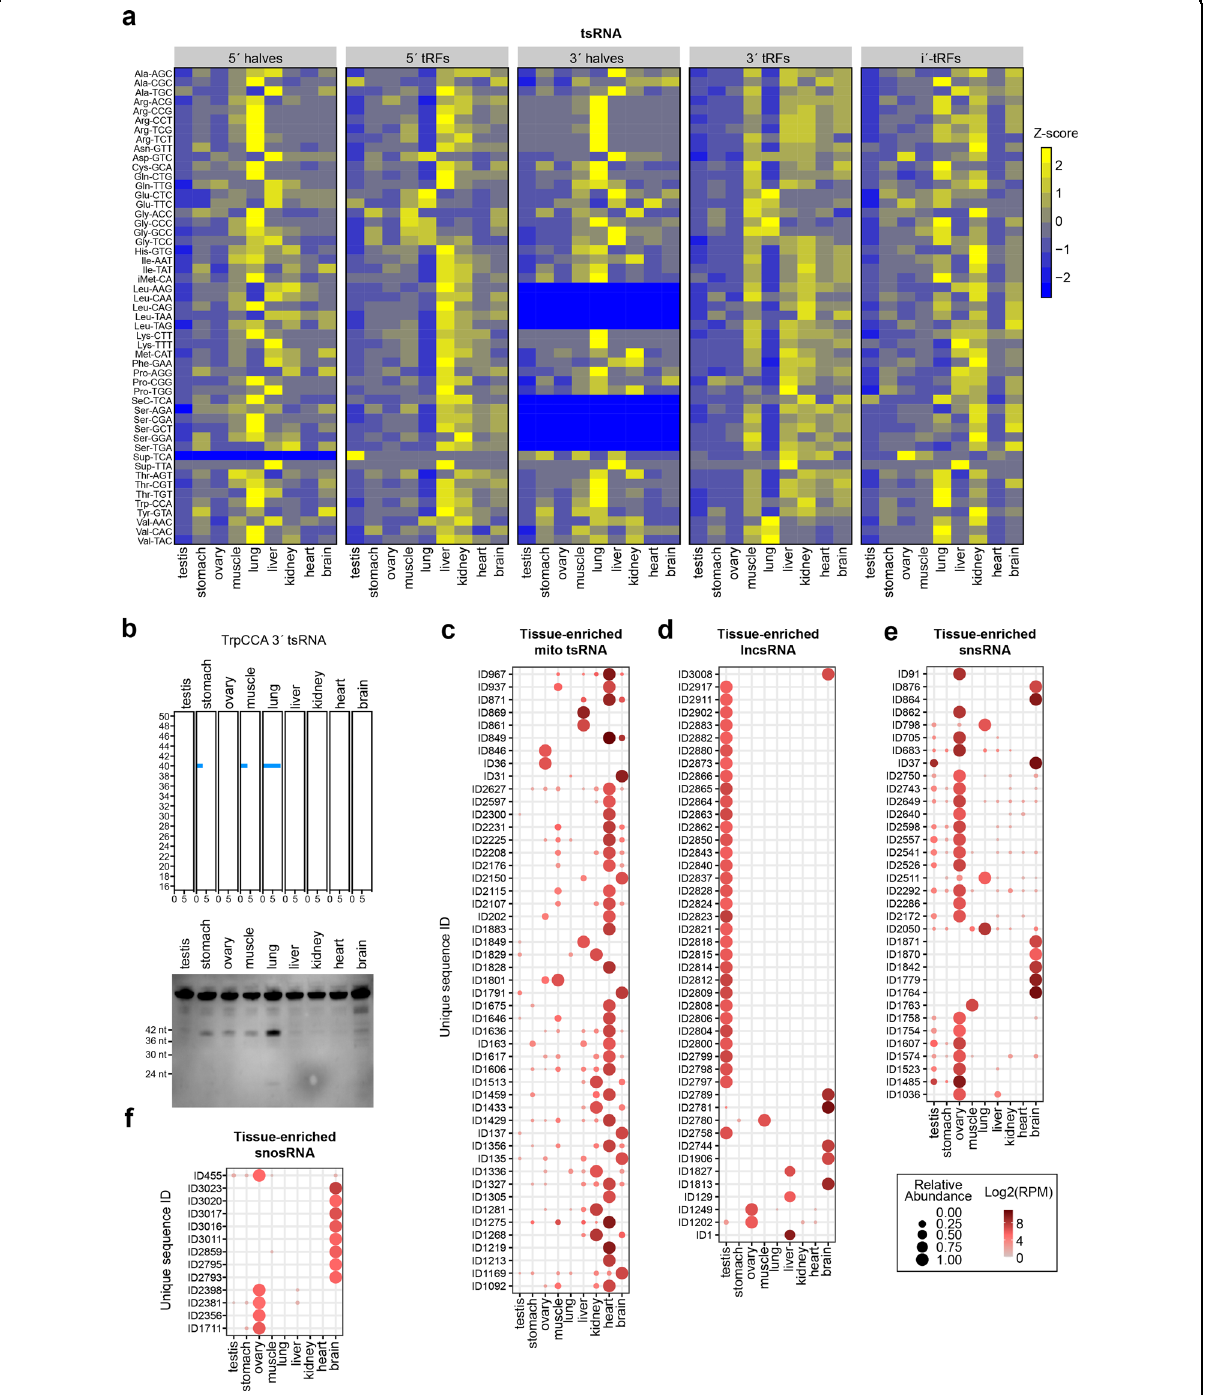
Fig. 6 Tissue-enriched sRNAs. a Heatmap of the relative abundance of tsRNA\s of different types in the indicated mouse tissues. b Detection of lung-enriched TrpCCA 3 ′ tsRNAs by Northern blotting. c – f Dot plot showing expression patterns of tissue-enriched mitochondrial tsRNAs (TSI > 0.95, RPM > 70 in at least one tissue) ( c ), lncsRNAs (TSI > 0.95, RPM > 50 in at least one tissue) ( d ), snsRNAs (TSI > 0.95, RPM > 50 in at least one tissue) ( e ), and snosRNAs (TSI > 0.95, RPM > 30 in at least one tissue) ( f